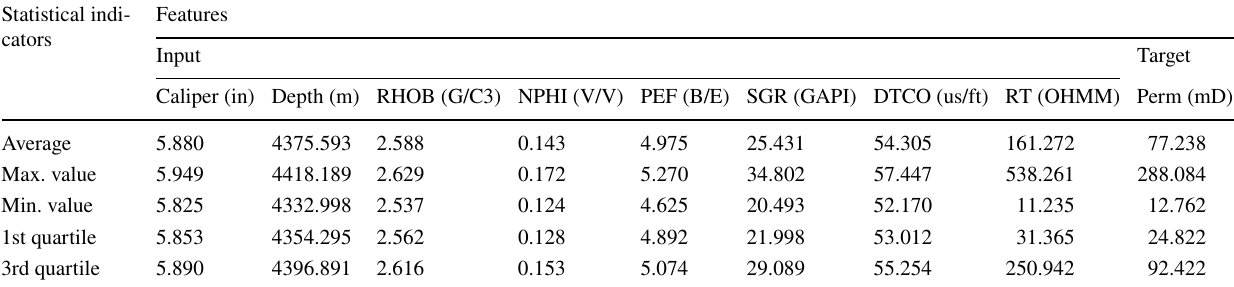
Fig. 5 Heat map of the correla- tion matrix of petrophysical logs and permeability over the studied depth interval at the studied